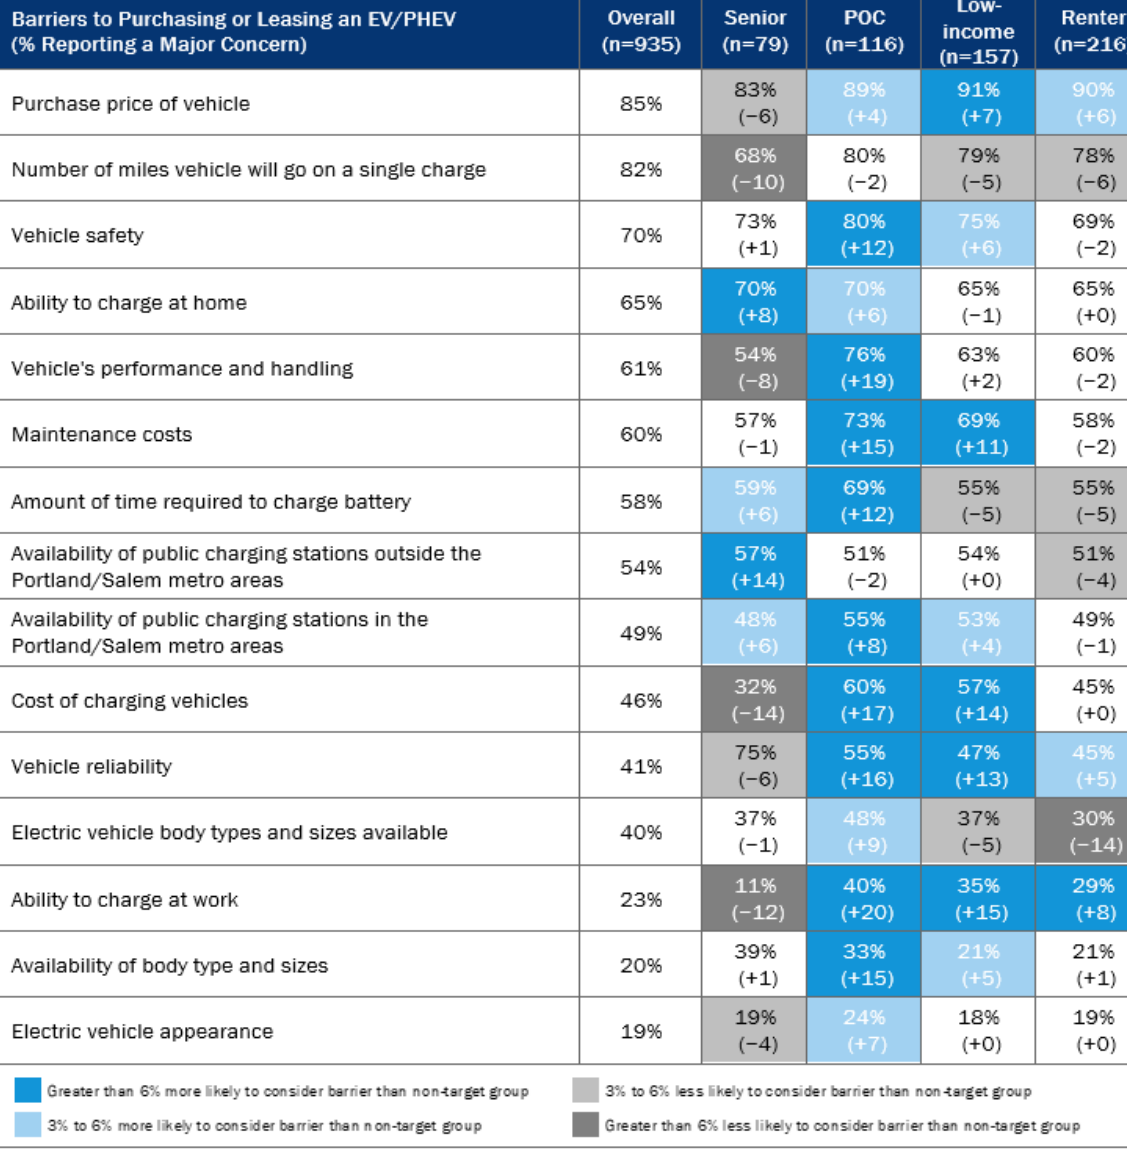
Figure 6. Differences in EV purchase barriers by demographic subgroups. Note: Numbers in parentheses indicate percentage differences between seniors compared to non-seniors, POC compared to white respondents, low-income compared to non-low-income respondents, and renters compared to owners. Analysis was conducted using combined Baseline and Wave 1 surveys to provide sufficient sample sizes to make inferences. Only those in the considerer and intender customer segments are included in this analysis. Some respondents declined to provide demographic information and these missing data were excluded from the analysis.